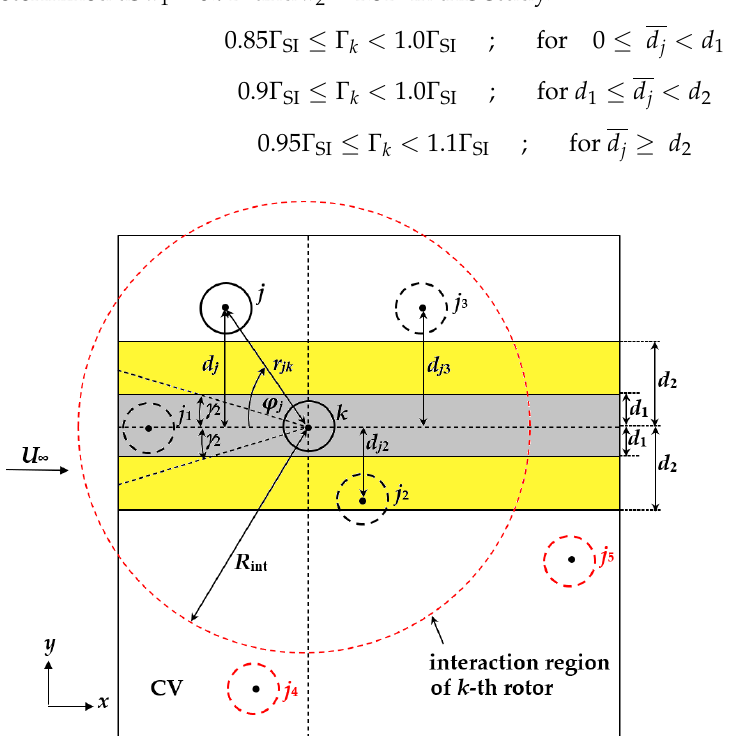
Figure 9. Definition of the angle γ 2 and three zones (in gray, yellow, and white) determining the searching range of circulation of the k -th rotor.